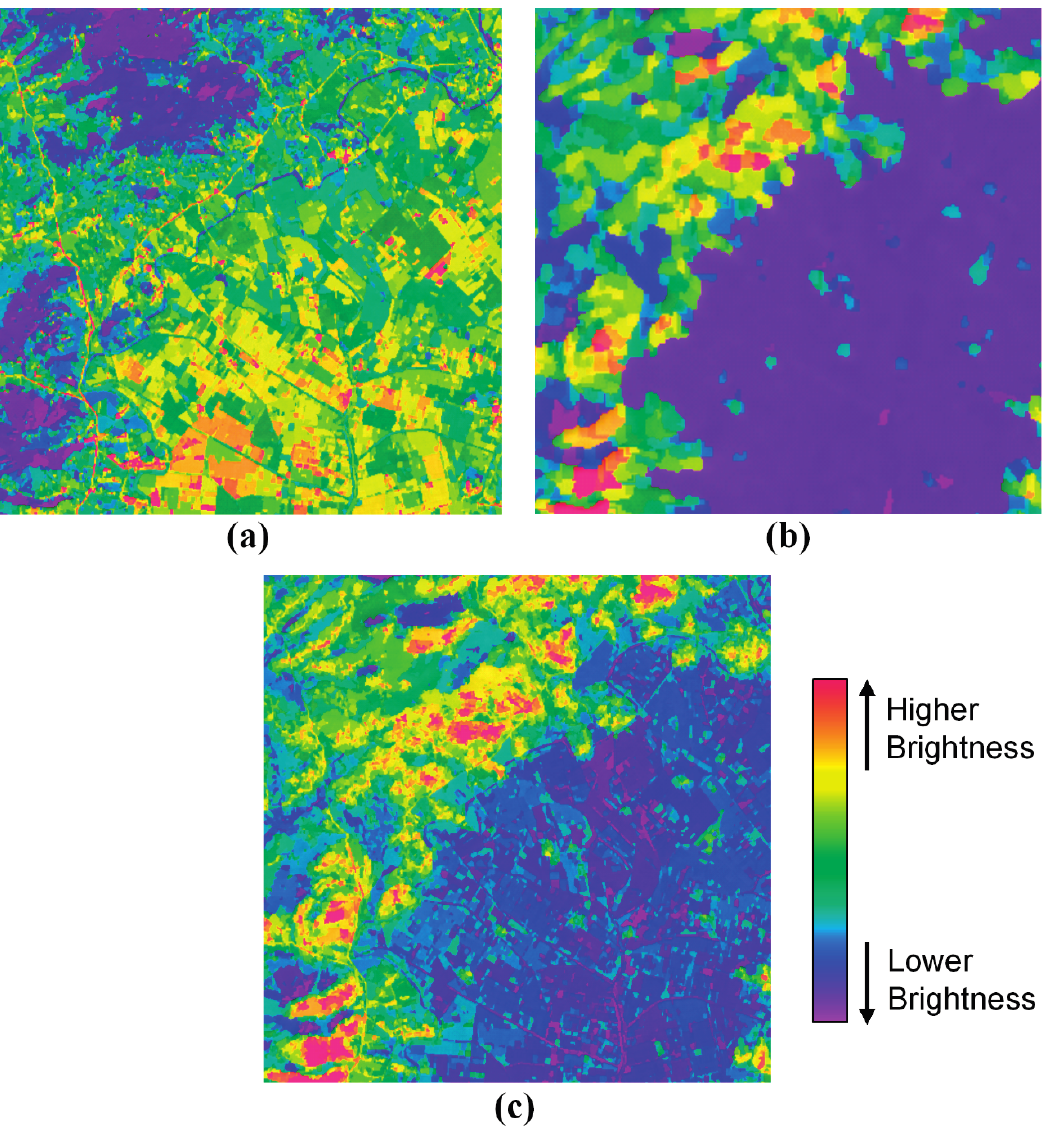
Figure 7. Image segmentation results from ( a ) the PAN image; ( b ) the TIR image and ( c ) the fused image of Figure 6 using the watershed